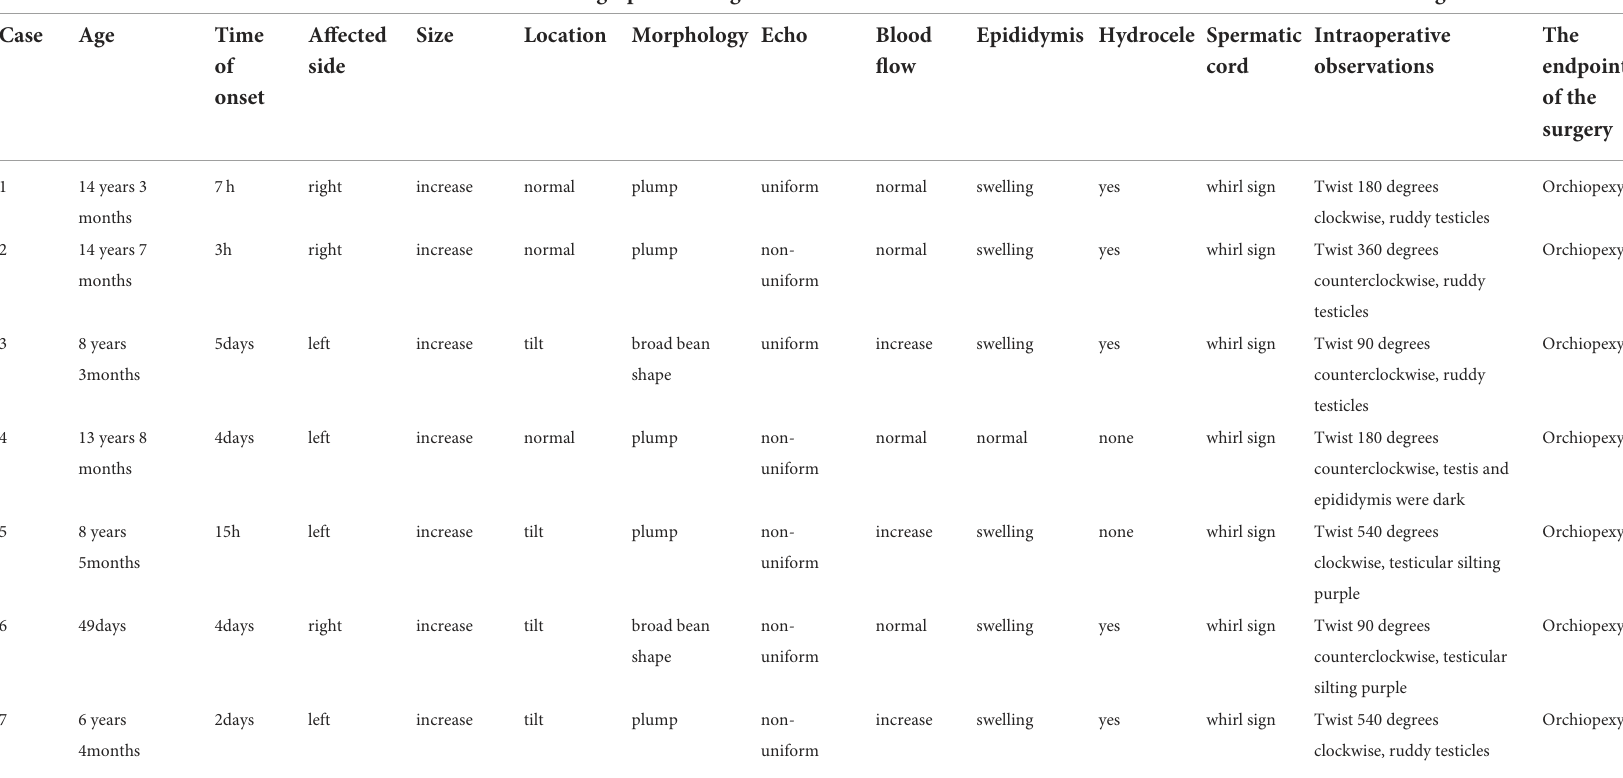
TABLE 1 The demographics, clinical characteristics, ultrasound performances and matching surgical results